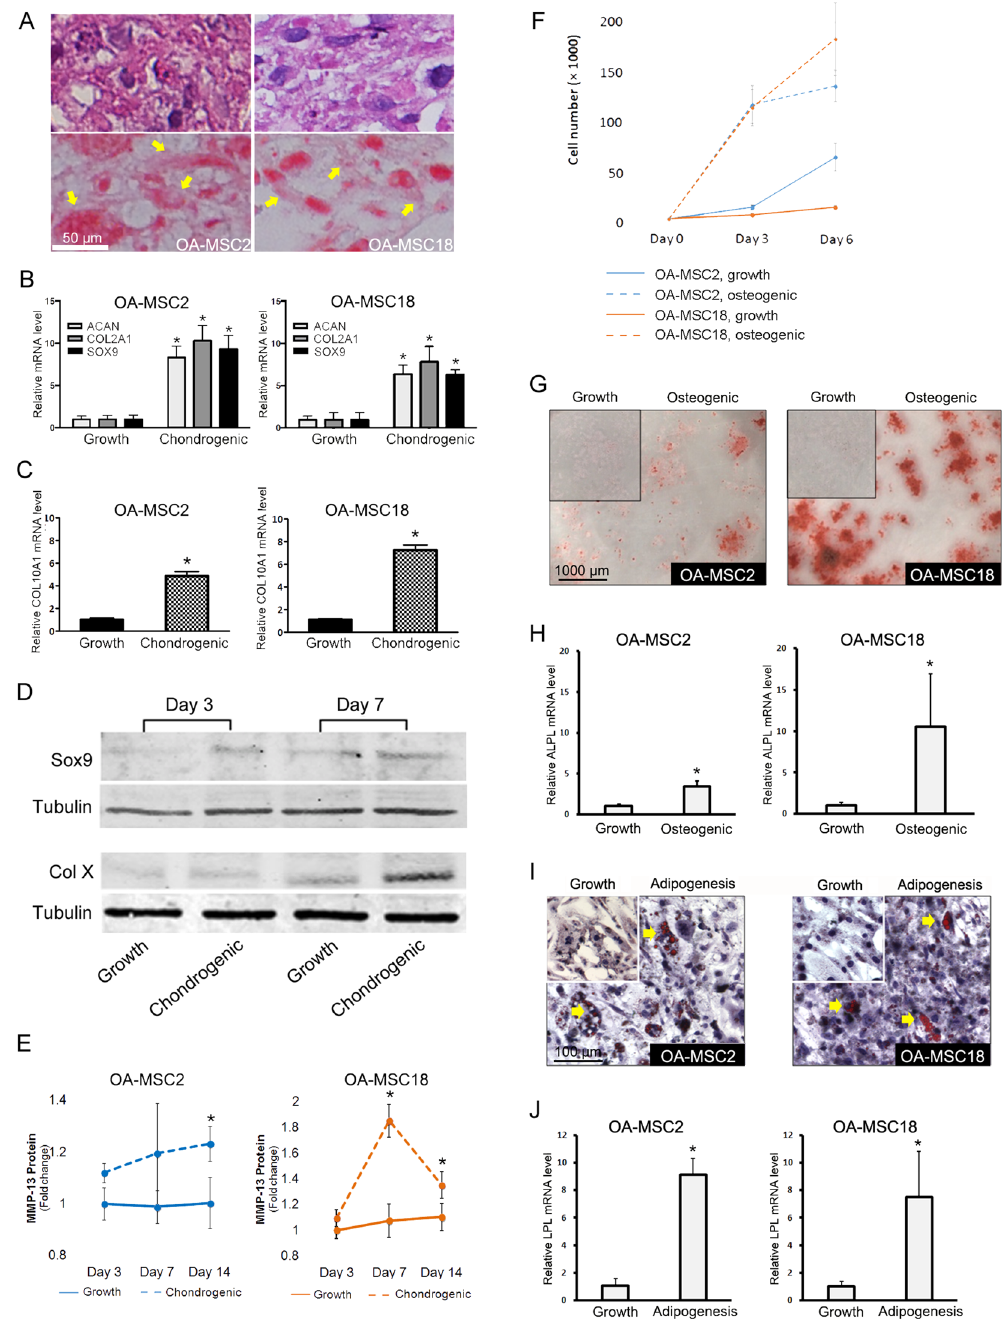
Figure 3. Differentiation analysis of clonal OA cartilage-derived MSCs. (A) Pellet cultures of OA-MSC2 and OA-MSC18 were sectioned, H&E stained (top panel) and Safranin O stained (bottom panel) after 21 days of induction with chondrogenesis medium and imaged at 20x magnification. Yellow arrows indicate areas of extracellular and pericellular matrix that stained positively for Safranin O. (B) ACAN, COL2A1, SOX9 mRNA expression levels and (C) COL10A1 mRNA expression level was quantified in monolayer culture following chondrogenesis induction. (D) Western blot analysis of SOX-9 and COL10 in OA-MSC2 after 3 days and 7 days in growth and chondrogenesis medium. Tubulin is used as a loading control. SOX-9 and respective tubulin loading control bands are from different parts of the same blot. COL10 and its respective tubulin loading control are from two different blots, but the loaded protein quantity was the same. (E) Active MMP-13 protein levels were quantified after 21 days in growth and chondrogenesis media by ELISA. (F) Cell proliferation rate of OA-MSC2 and OA-MSC18 was determined by quantifying viable cell number that results from culturing each cell line for 6 days in chondroprogenitor growth medium or osteogenesis induction medium. (G) OA-MSC2 and OA-MSC18 were stained with Alizarin Red following osteogenic induction for 21 days. (H) ALPL mRNA expression was quantified following osteogenesis induction. (I) Adipogenic induction of OA-MSC2 and